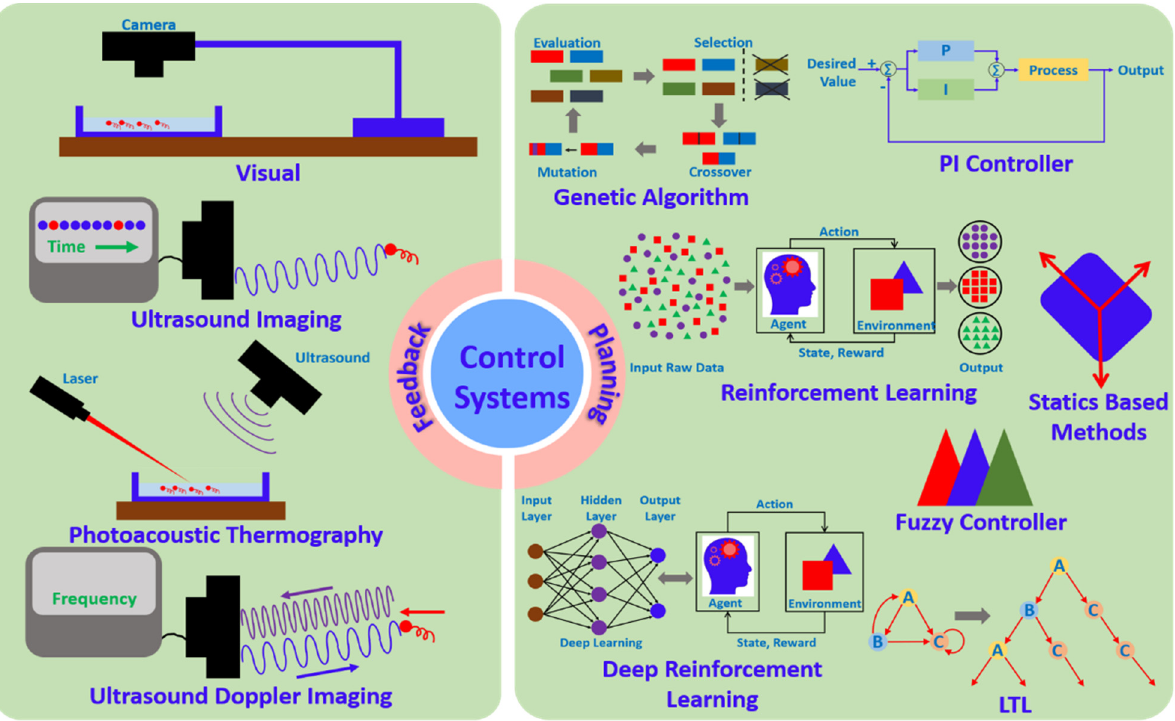
Figure 8. Schematic diagram showing different feedback and planning methods.